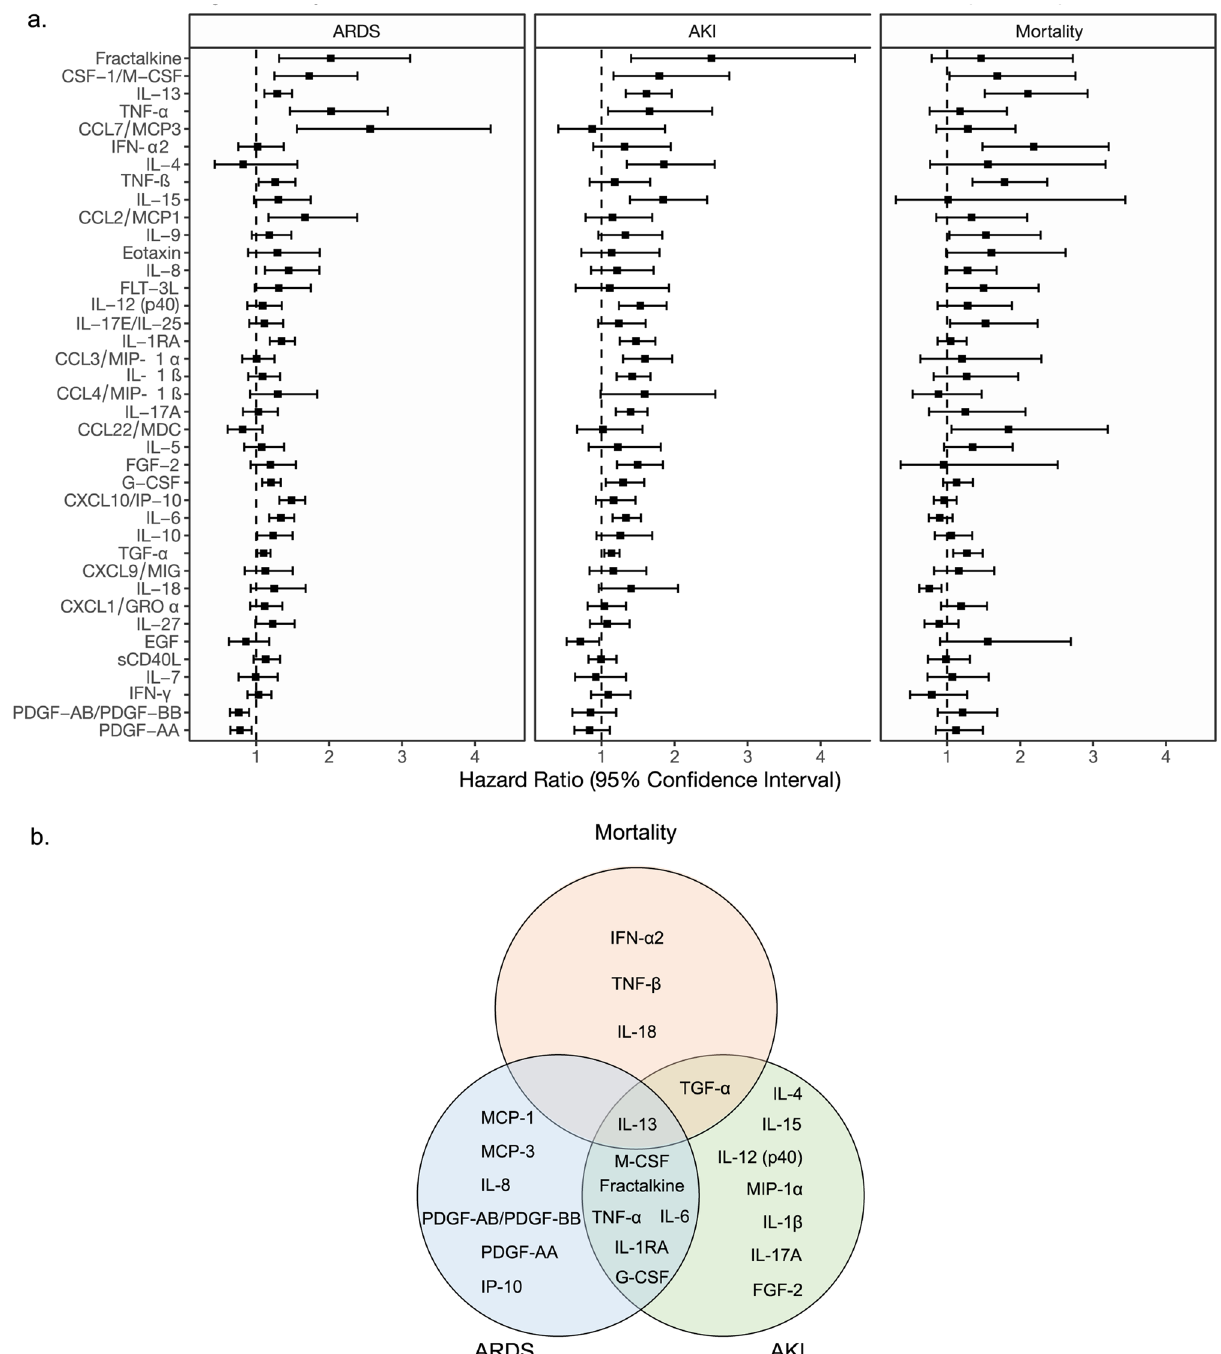
Figure 5. Associations between cytokine expression levels and clinical outcomes within COVID19 patients. ( a ) Forest plots representing the estimates of association for day 1 of hospital admission cytokine expression with clinical outcomes of mortality, need for intubation (ARDS), and development of acute kidney injury (AKI) among COVID-19 patients. Each box shows the estimated Hazard Ratio (HR) and each whisker represents the 95% Confidence Interval (CI) of the HR. Cox Proportional Hazard (PH) models with robust standard errors were used to compute all estimates with time 0 as day 1 of hospital admission. ( b ) Venn diagram showing 23 cytokines significantly associated (p < 0.05) with clinical outcomes such as mortality, ARDS, and development of AKI after pvalue adjustment for multiple